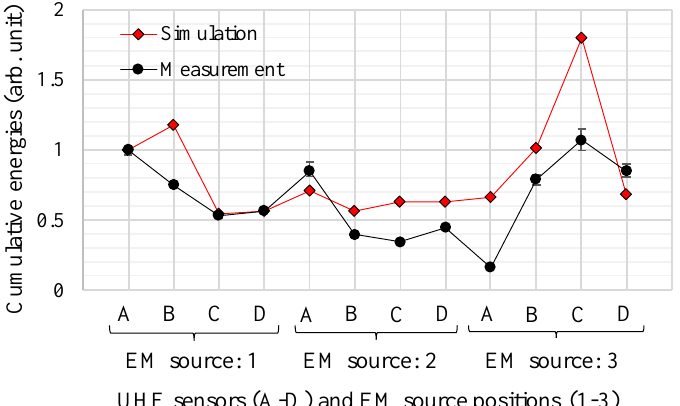
Figure 14. Simulated and measured cumulative energies for each UHF sensors and EM wave source.